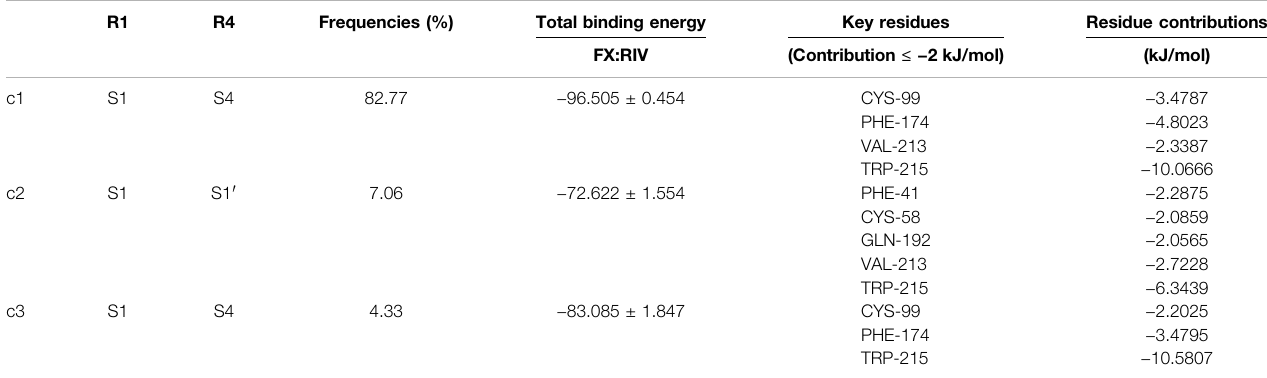
TABLE 4 | Top three binding modes in the Y99C mutant.